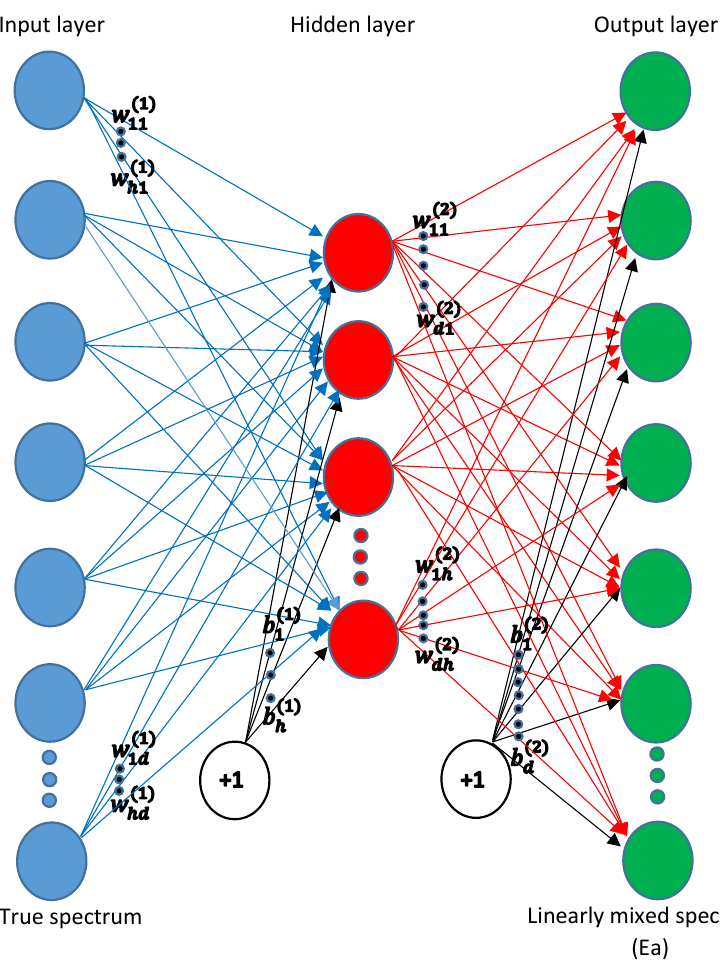
Figure 2. The feedforward neural network that is applied for the